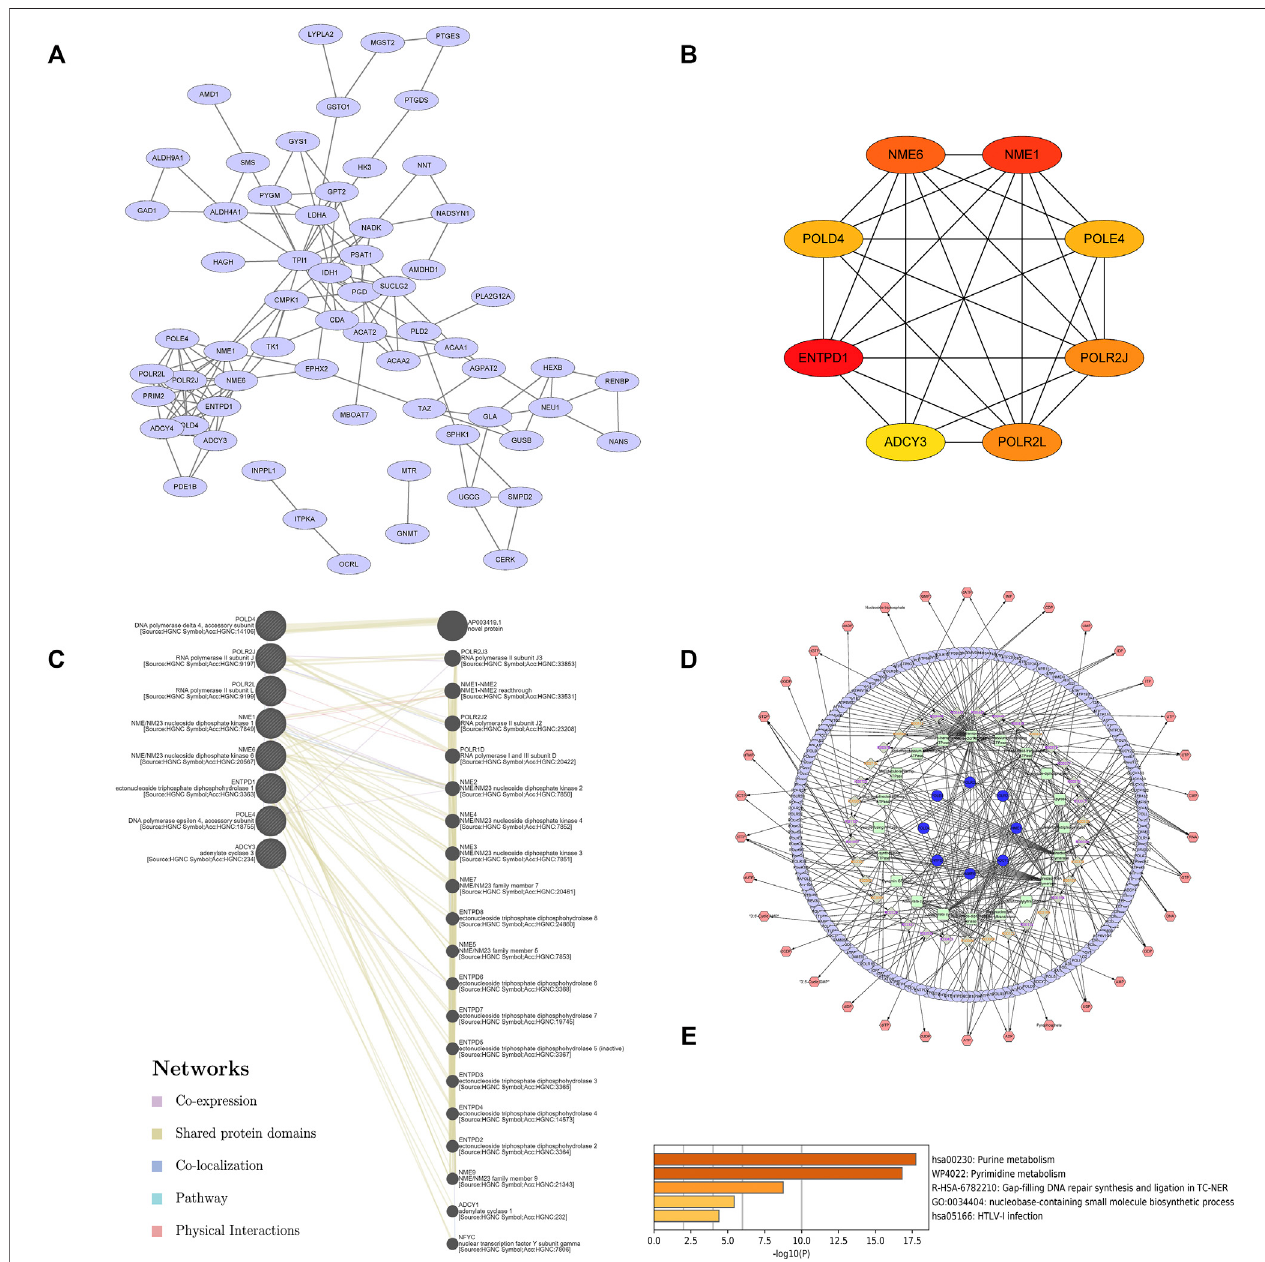
FIGURE 4 | Hub genes were identi fi ed by the PPI network complex of metabolic DEGs. (A) Sixty-six DEGs with 66 nodes and 119 edges were displayed using STRING. (B) The 8 most important hub genes were screened using the Cytoscape software plugin cytoHubba. The PPI network data from STRING was further analyzed by Cytoscape and hub genes identi fi cation was performed by cytoHubba. (C) Gene – gene interaction networks and functions of 8 hub genes in GeneMANIA. (D) The landscape of metabolic network of hub genes. (E) Enriched pathways of hub genes in